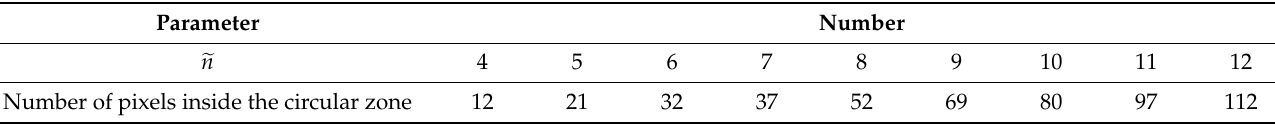
Table 1. Number of pixels inside the circular zone for each number of (cid:101) n .